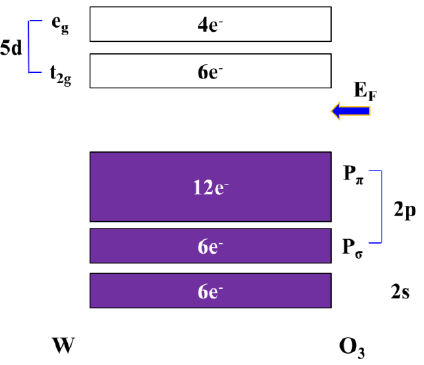
Figure 1. Simple sketch of band diagram of WO 3 , where E F : Fermi level in the location. Filled energy states are colored.